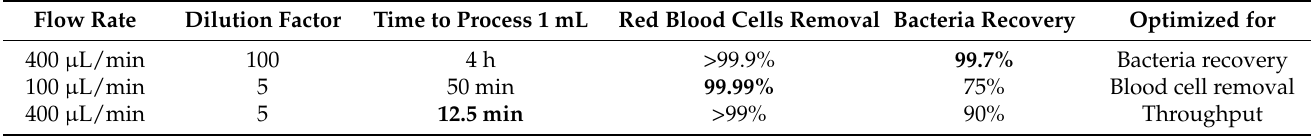
Table 1. Comparison of label-free microfluidic continuous flow methods for separation of bacteria from red blood cells. All numbers are per channel, adapted from [81], licensed under CC BY